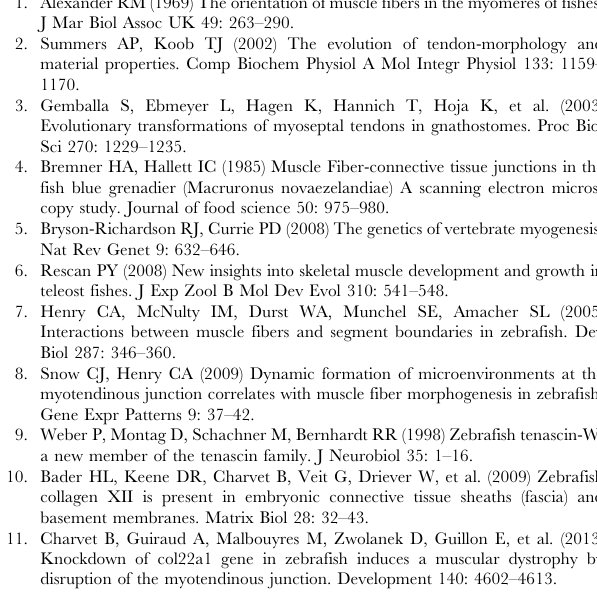
Figure S1 Laminin and fibronectin localisation. (A and B) Frontal sections through the trunk of a 9 dpf trout embryo. Laminin ( A ) and fibronectin ( B ) are concentrated at somite boundaries. Scale bars in A and B, 20 m m. (TIF) Figure S2 Immunolocalisation of H3P in myoseptal cells in a frontal section through the trunk of a 21 dpf